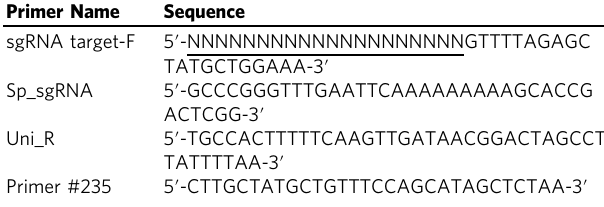
Table 2 Primers used for gRNA cloning in the fi rst PCR.